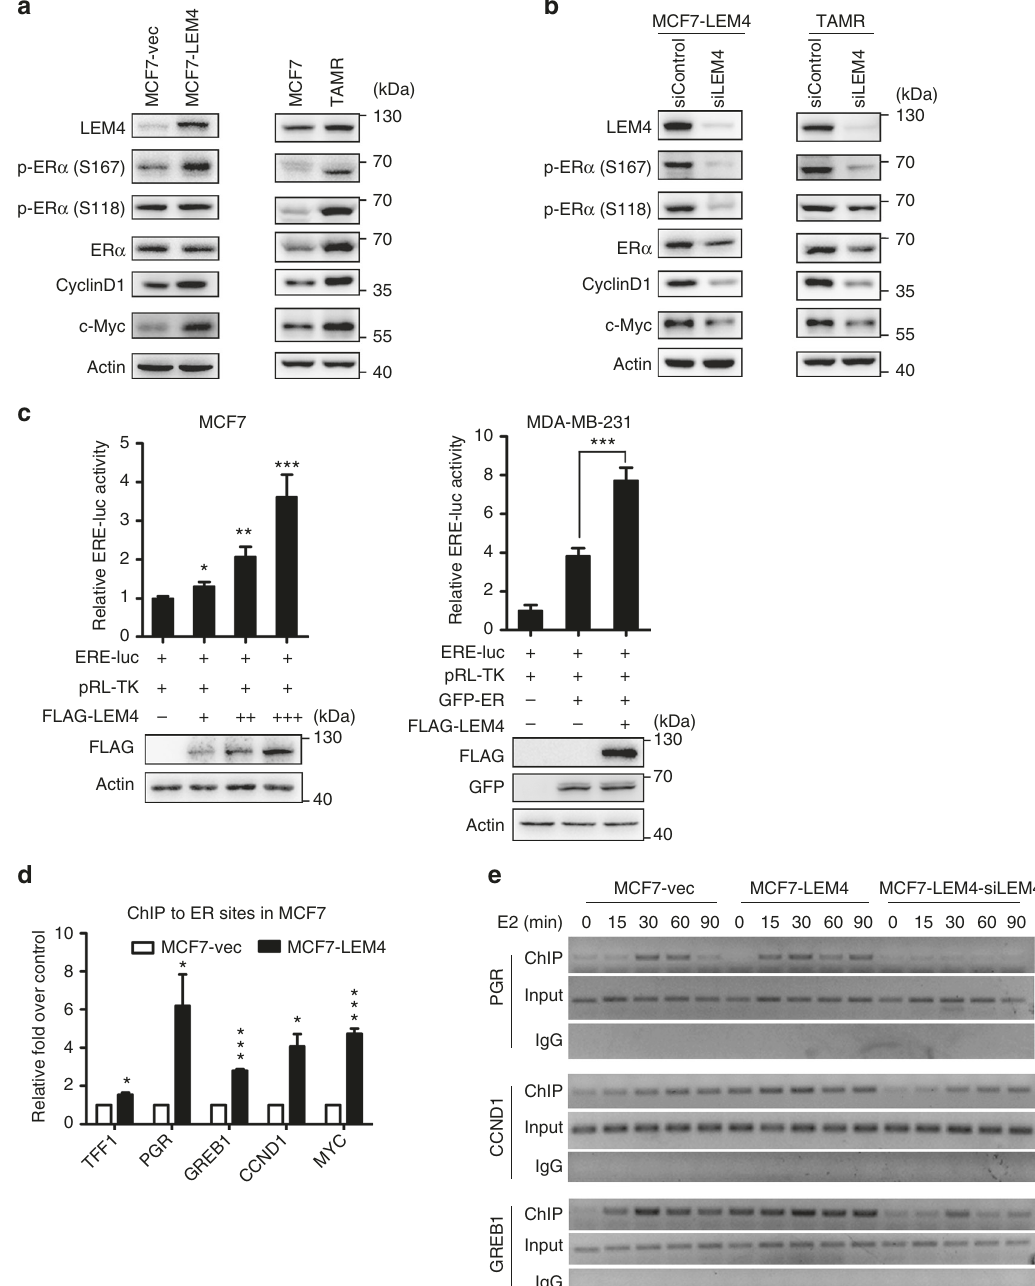
Fig. 6 LEM4 induces ER α transactivation activity. a Immunoblot analysis of the phosphorylation of ER, Cyclin D1, and c-Myc in MCF-LEM4 and MCF7- TAMR cells. b Immunoblot analysis of the phosphorylation of ER, Cyclin D1, and c-Myc in LEM4-depleted MCF7-LEM4 and LEM4 knocked-down MCF7- TAMR cells. c Luciferase assay. ER + MCF7 and ER α -negative MDA-MB-231 cells were transfected with ERE-Luc and other indicated plasmids. Following incubation for 48 h, luciferase activity was measured and normalized to Renilla. Results are the mean ± s.e.m. of three independent experiments performed in triplicate. d ER α ChIP assay of known ER-binding sites in ER α target genes was performed in MCF7-LEM4 cells incubated in estrogen-depleted medium (5% charcoal-stripped serum in phenol red-free DMEM) for 72 h before treatment with vehicle, 10 nmol L − 1 E2 for 45 min. e Time course ChIP study of the endogenous ER α with the estrogen response elements in the promoter region of the ER α target genes. MCF7, MCF7-LEM4, and LEM4-depleted MCF7- LEM4 cells incubated in estrogen-depleted medium (5% charcoal-stripped serum in phenol red-free DMEM) for 72 h before treatment with vehicle, 10 nmol L − 1 E2. ChIP analysis was conducted by using anti-ER α antibody. * P < 0.05, ** P < 0.01, *** P < 0.001. Tukey ’ s multiple comparisons test